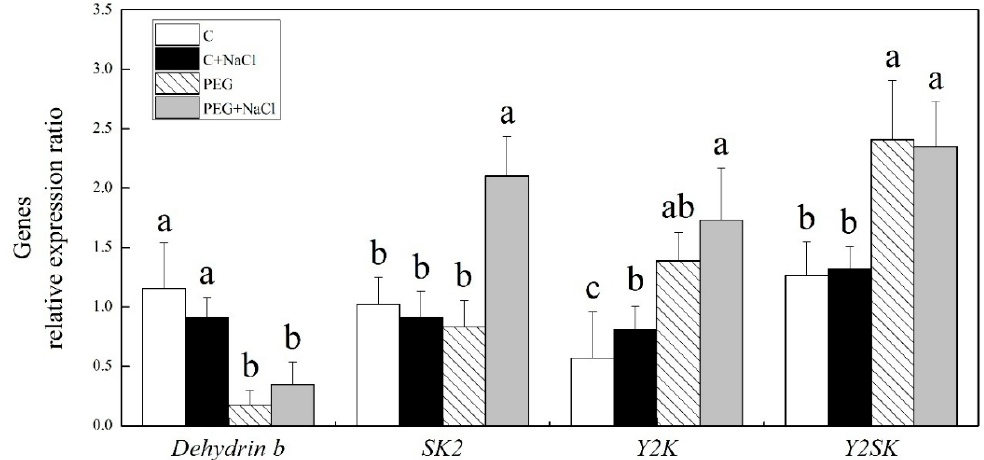
Figure 8. Effects of seeds soaking with water or NaCl (1 mM) on the relative expression ratio of genes encoding dehydrins after seven days of germination under normal conditions and water stress induced by 19% polyethylene glycol (PEG) 6000. Vertical bars indicate ±SE of the mean ( n = 6). Different letters above columns indicate significant differences ( p ≤ 0.05).